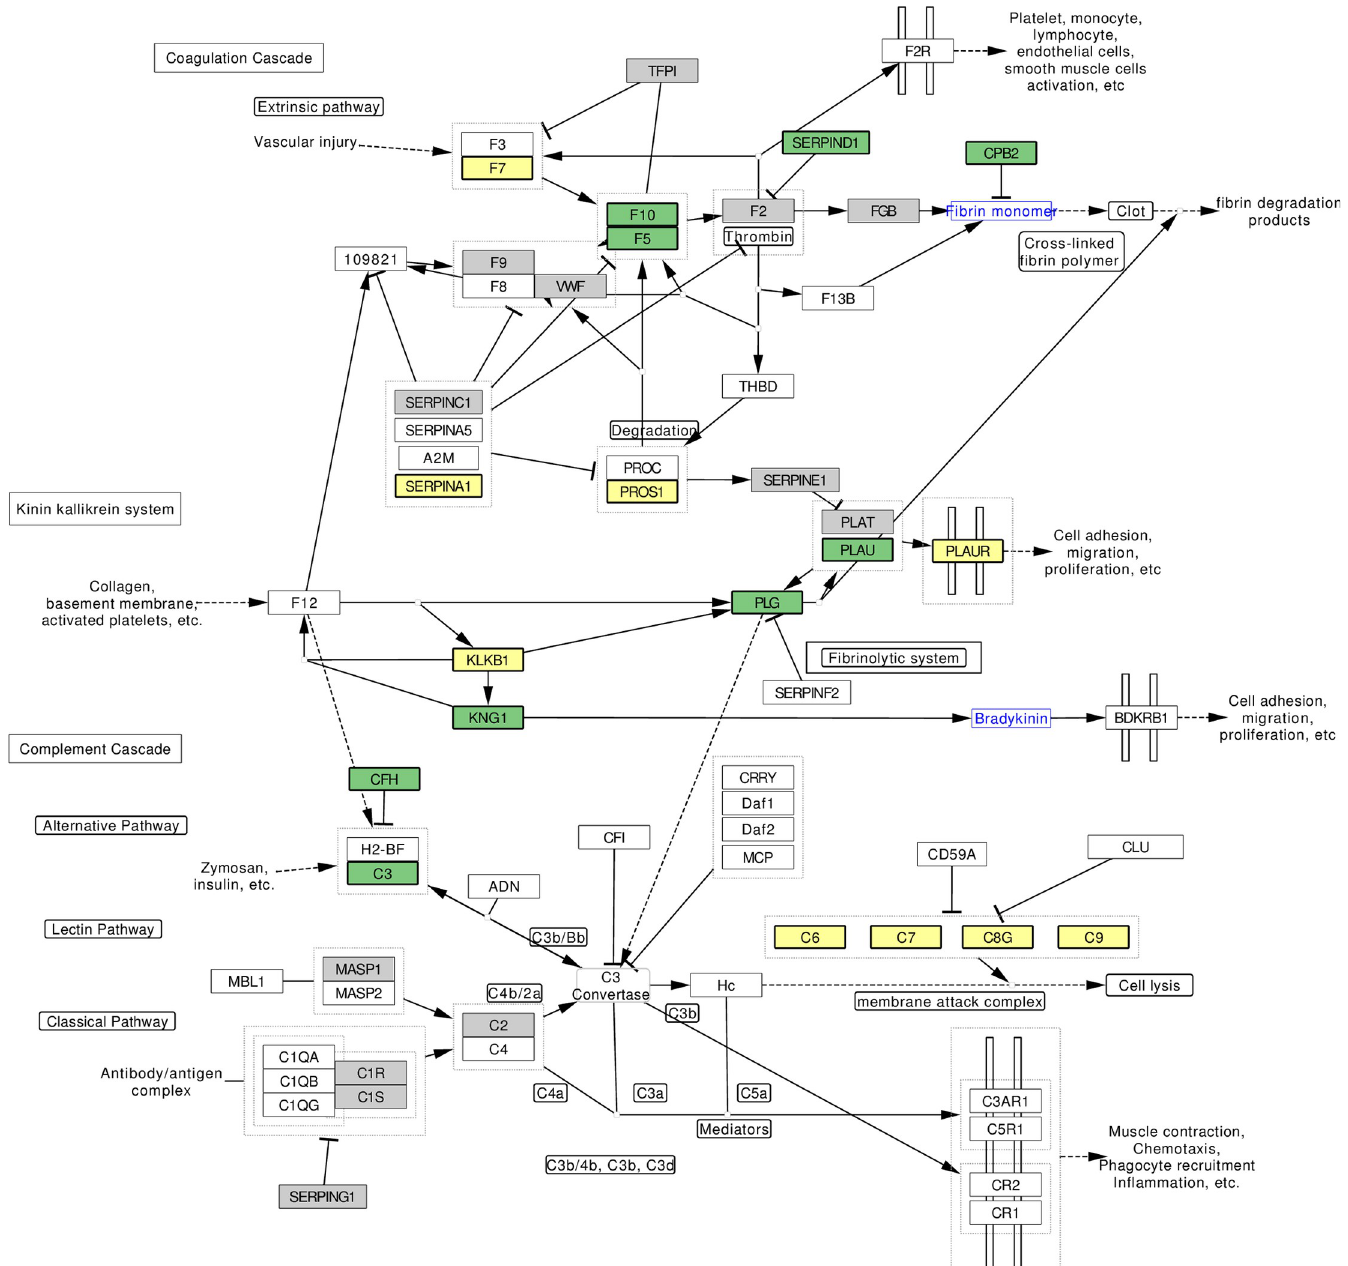
Fig 3. Mapping Clinical Outcome Information to the Complement and Coagulation Pathway (See Attached File). The Coagulation and Complement pathway is shown in this diagram, (source: https://www.wikipathways.org/index.php/Pathway:WP558.) Colored boxes represent results from random forest survival analyses. Gray boxes represent proteins associated with heart failure when the full sample was analyzed. Green boxes represent proteins that were associated with HF after analysis of the non-CKD sub-group. Yellow boxes represent proteins associated with HF after analysis of the CKD sub-group, including F7(Coagulation factor VII precursor), SERPINA1(Alpha-1-antitrypsin precursor), PROS1(Vitamin K dependent protein S precursor), PLAUR(Urokinase plasminogen activator surface receptor), KLKB1 (Plasma kallikrein precursor), Complement(C)6, C7, C8-gamma chain, C9. Coagulation factors 3, 8, 12 and MASP2 were not